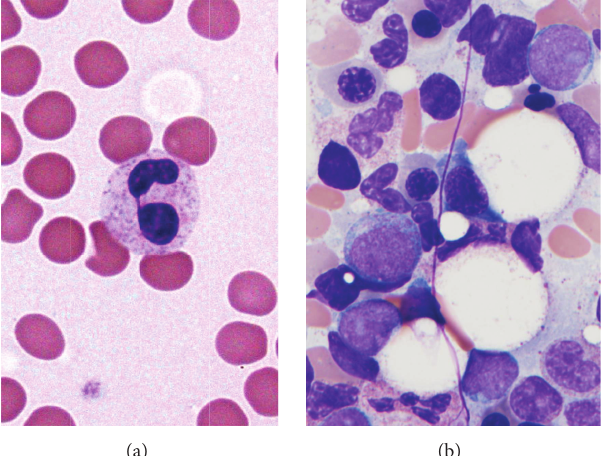
Figure 2: Therapy-related myelodysplastic syndrome. (a) Peripheral blood (Wright-Giemsa, 100x) showed a leukopenia with neutropenia and circulating pseudo-Pelger-Huet cells with bilobed hyposegmented nuclei. Peripheral blood also showed a mild normocytic anemia and thrombocytopenia. (b) Bone marrow aspirate (Wright-Giemsa, 100x) showing a mild increase in blasts (7% of cellularity) with a high nuclear to cytoplasmic ratio, vesicular chromatin, and prominent nucleoli with variable granularity. No Auer rods were identified. A rare dysplastic erythroid cell with a blebbed nucleus is noted.